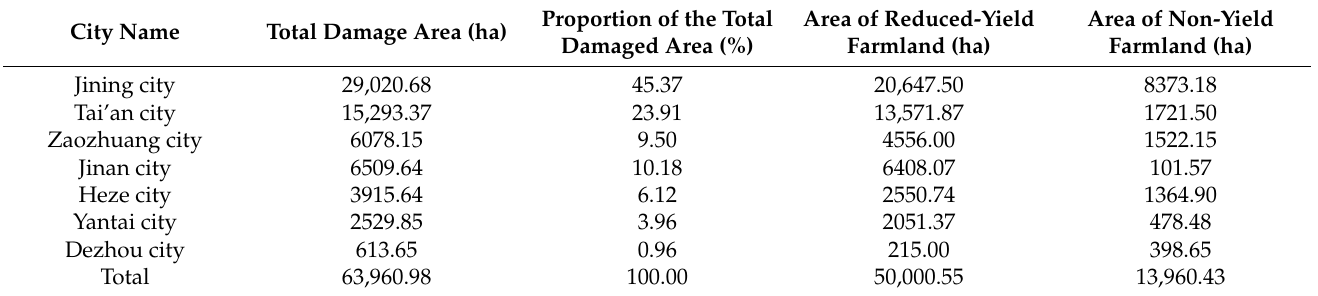
Table 2. Current area of damaged farmland.